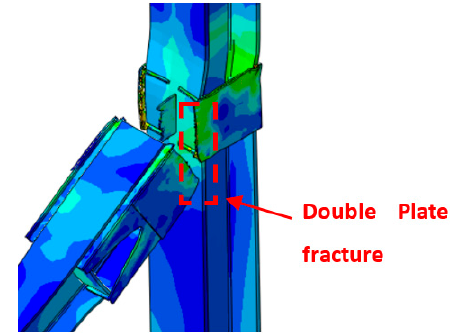
Figure 13. FEM mode of failure for strengthening scheme J-S-S-EXwith A36 materials.